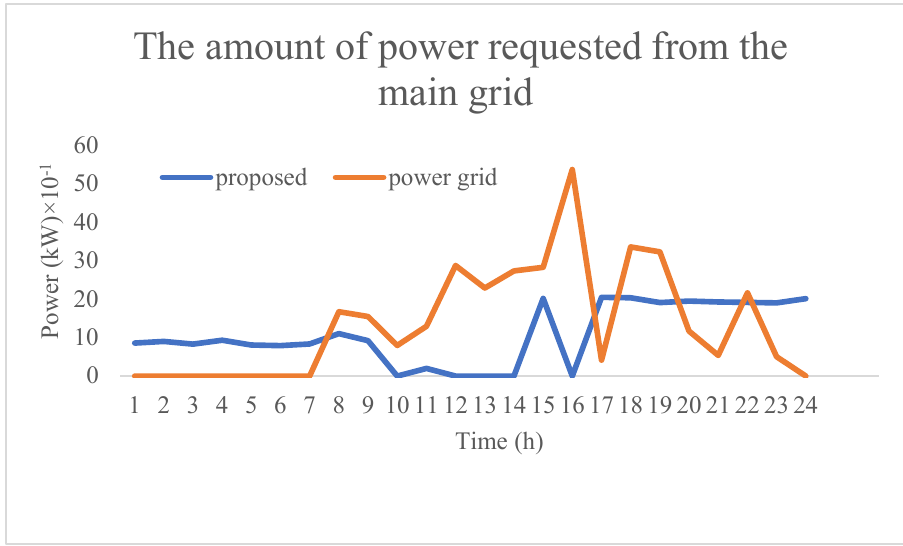
Figure 20. The amount of power requested from the main grid in 24 h a day.